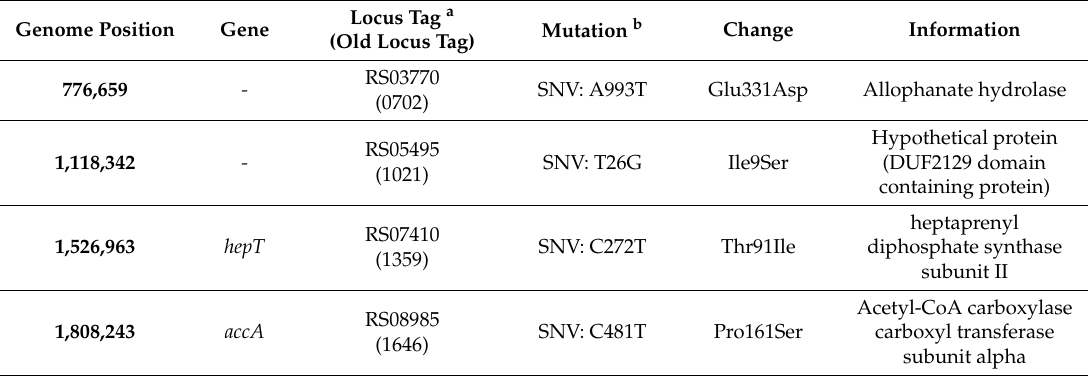
Table 4. Mutations of evolved strain (SaROEO) in comparison with Staphylococcus aureus USA300 (SaWT). Single nucleotide variation (SNV).